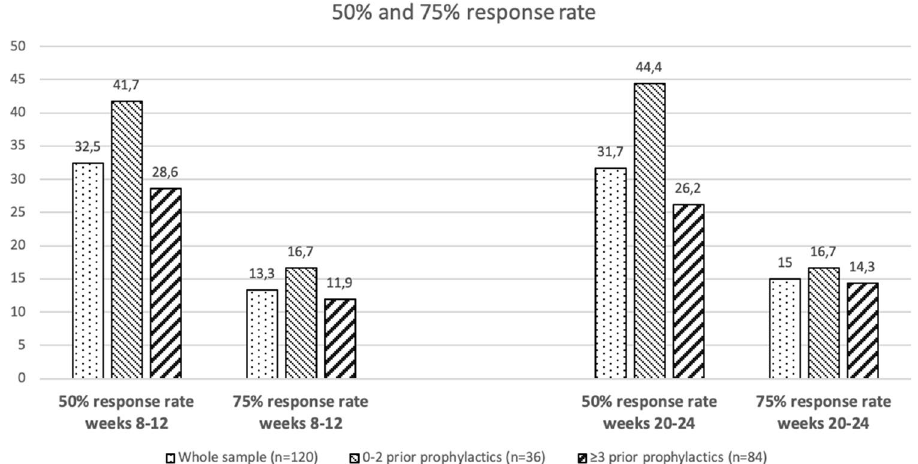
Figure 3. Fifty percent and 75% response rates by prophylactic category at weeks 8–12 and 20–24. Analysis was intention-to-treat and used the last observation carried forward imputation